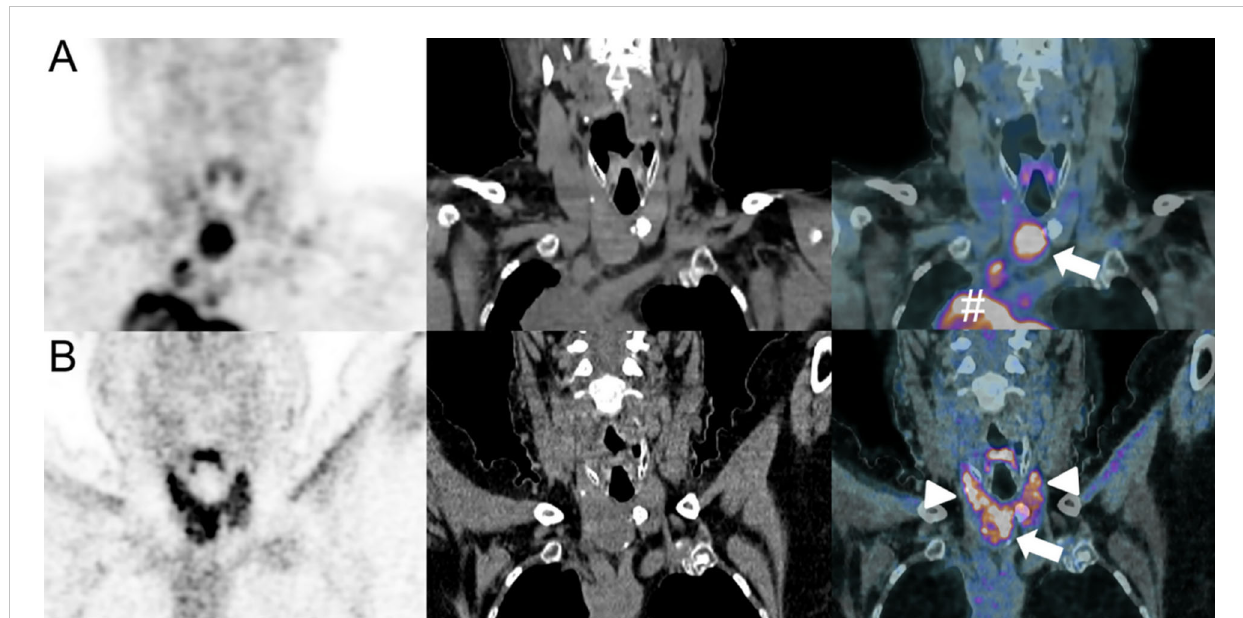
FIGURE 10 Immune-related thyroiditis in a 50-year-old female with lower leg Meckel-cell carcinoma who developed mediastinal metastatic spread as shown on baseline 18 F-FDG-PET/CT [coronal PET, CT and merged PET/CT images, # (A) ]. A thyroid nodule was also present [arrow, fused PET/CT image (A) ]. Pembrolizumab (anti-PD-1) was administered. Follow-up 18F-FDG-PET/CT at 6 months showed disappearance of mediastinal disease and decrease in metabolic activity of the thyroid nodule [arrow, fused PET/CT image (B) ]. However, a marked increase in thyroid activity was also evident, consistent with a thyroiditis [arrowheads, fused PET/CT image (B)